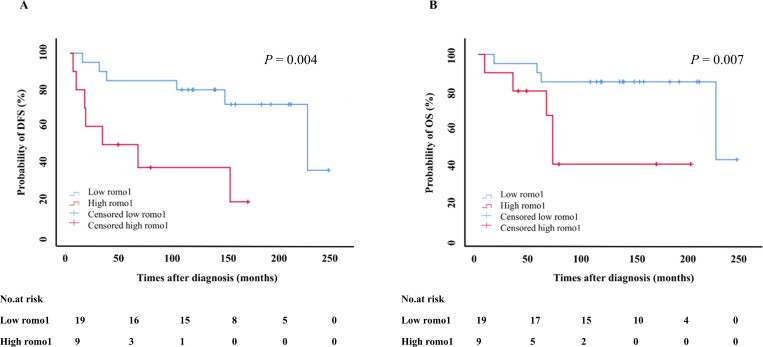
Kaplan–Meier survival curves for disease free survival (DFS) (A) and overall survival (OS) (B) in stage I patients. P-values were determined using the log-rank test. romo1, reactive oxygen species modulator 1.